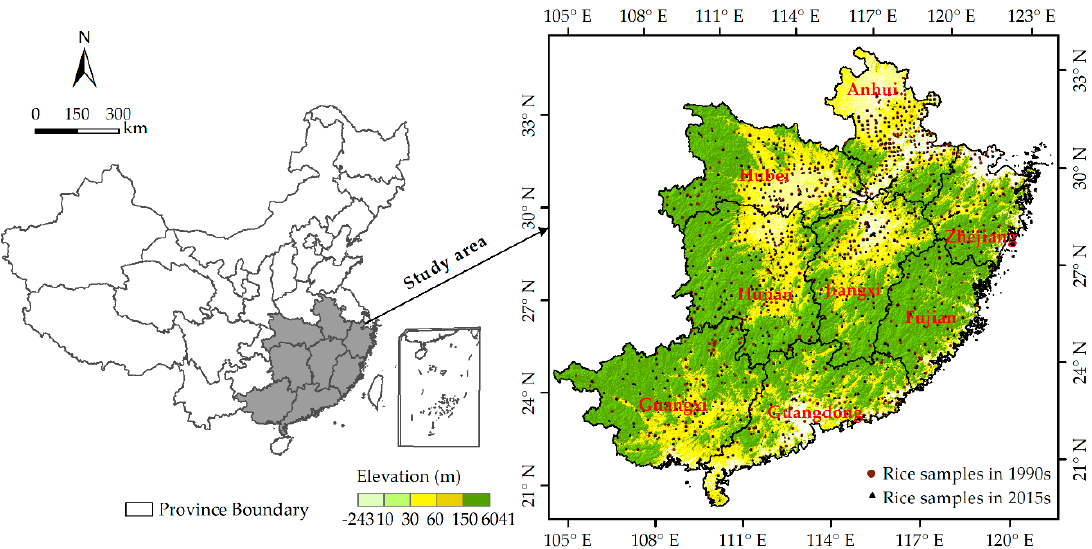
Figure 1. Study area and spatial distribution of rice samples (1053 samples in 1990s and 1109 samples in 2015s).